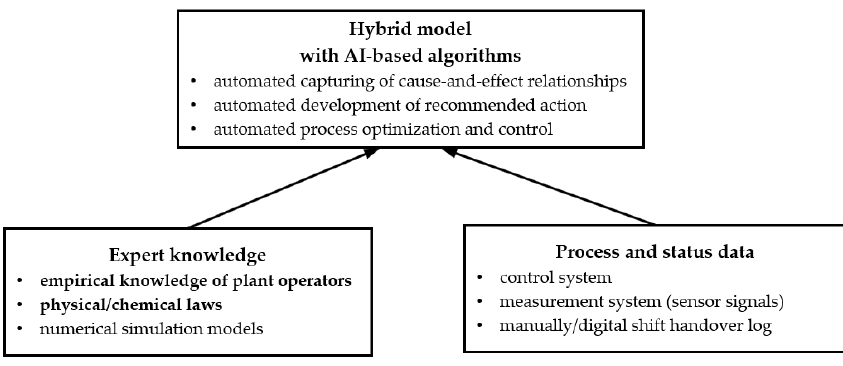
Figure 2. AI-based hybrid model.